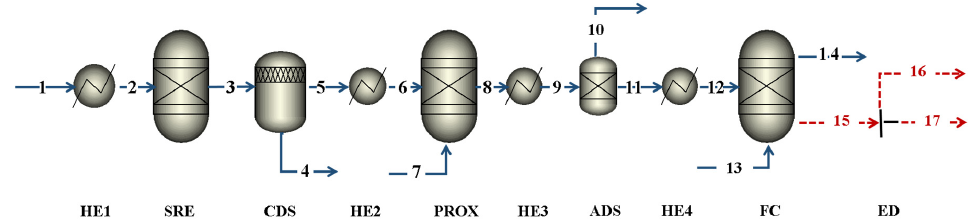
Figure 2. Aspen Plus flowsheet of the process used for the analysis of the energy production in FC